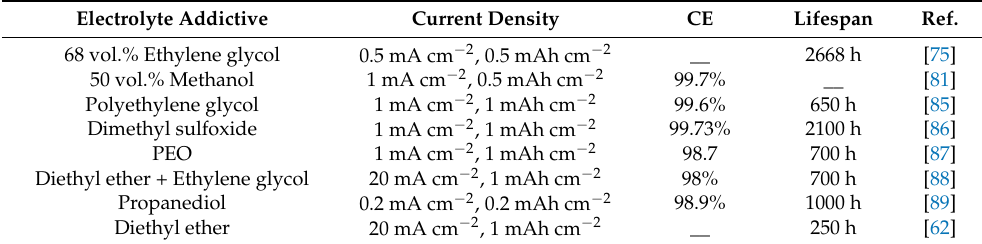
Table 2. Recent publications focused on organic additives in ZIBs. Electrolyte